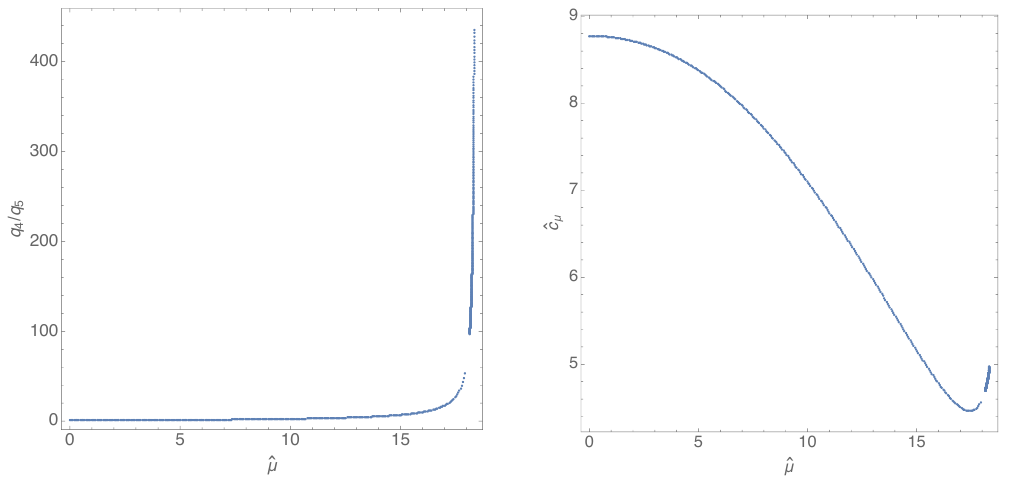
Figure 2 . Left panel : the ratio ( q 4 =q 5 ) y =1 evaluated at the as a function of ^ (cid:22) . Right panel : the dimensionless speci(cid:12)c heat ^ c (cid:22) as a function of ^ (cid:22) .